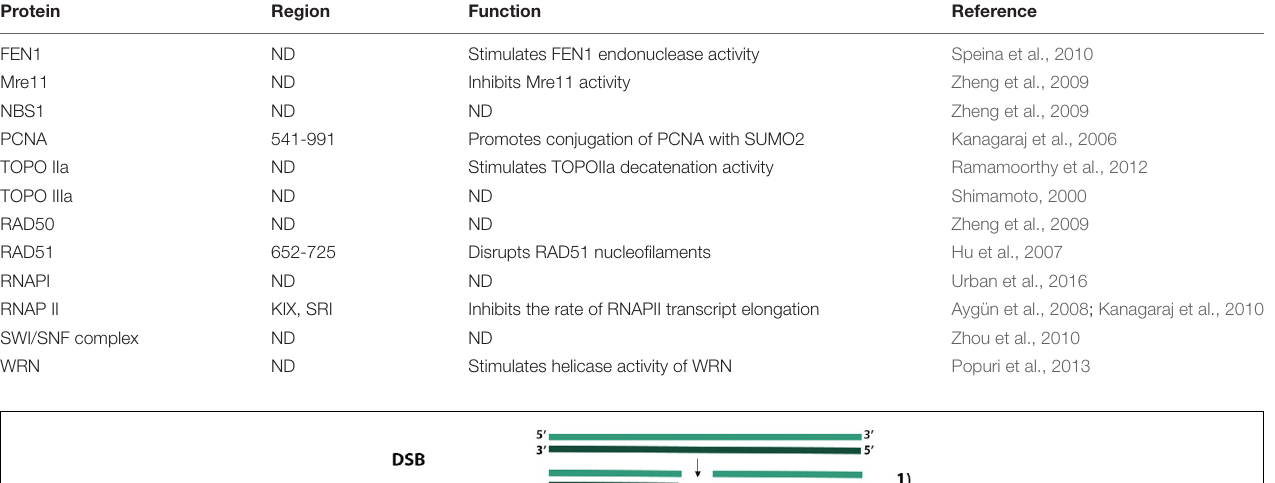
TABLE 1 | Protein–protein interactions reported for RECQL5.